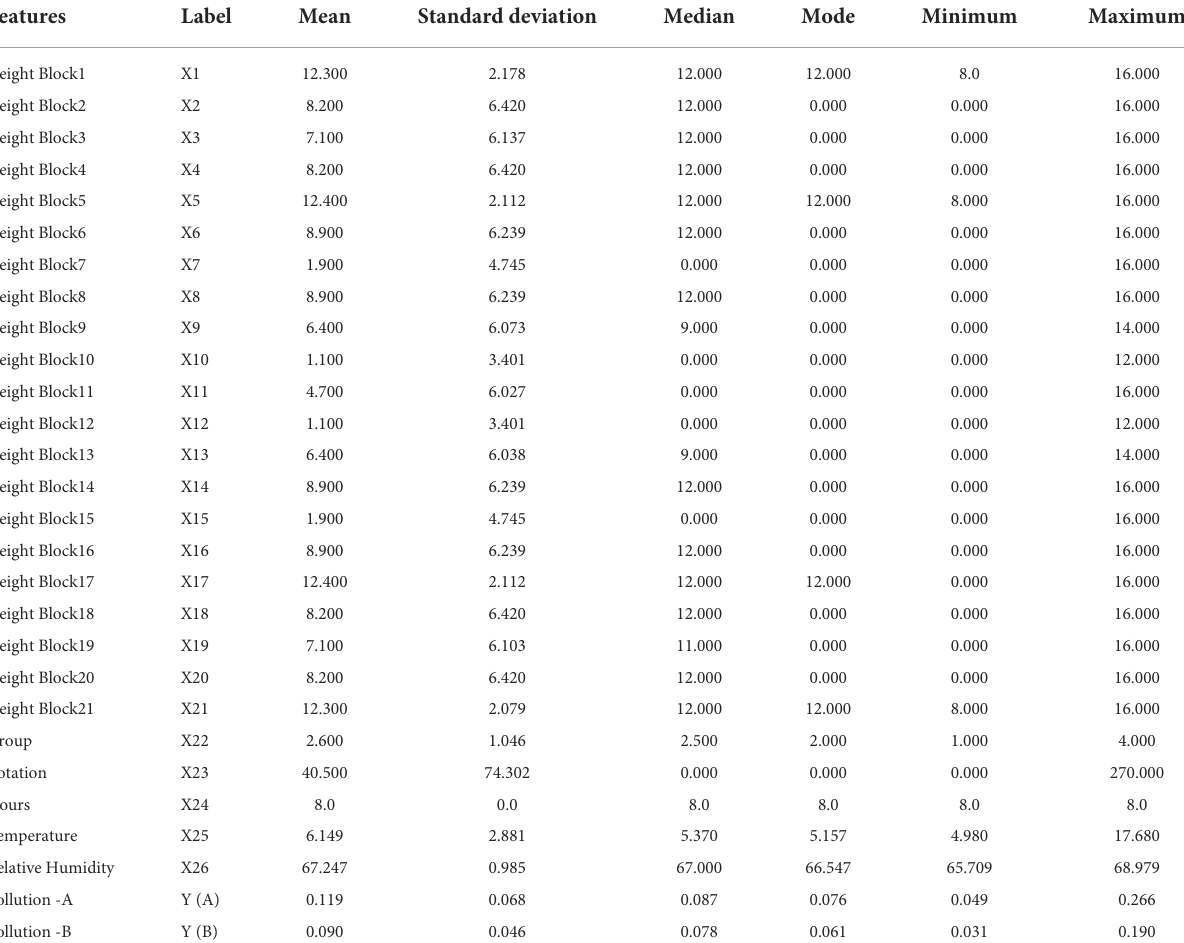
TABLE 4 Statistical analysis of